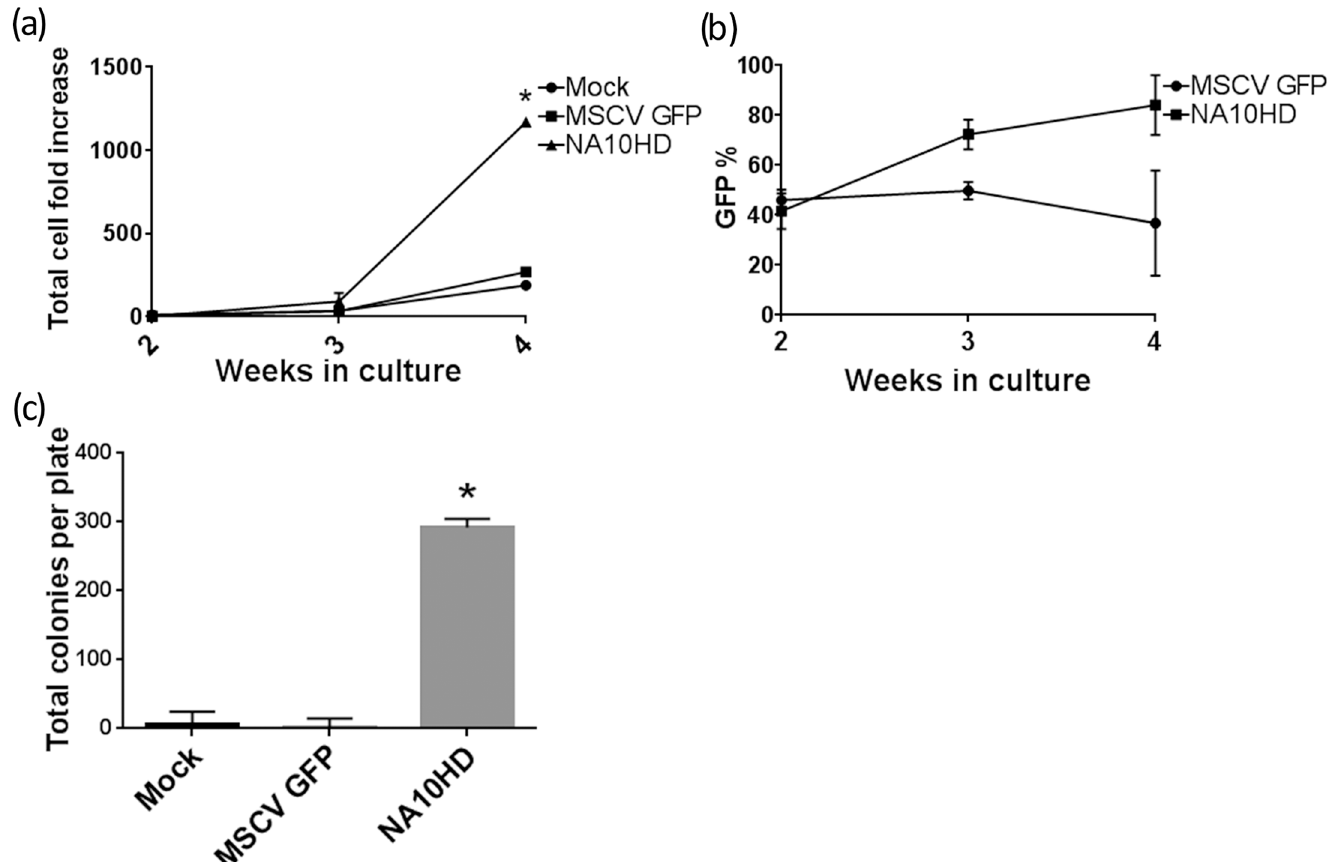
Fig 2. Biologic activity of NUP98-HOXA10HD in mouse bone marrow. (a) Growth curve of lineage depleted C57BL/6 mouse bone marrow cells transduced with GFP control or NUP98-HOXA10HD-GFP vector (NA10HD) as compared to untransduced mock cells grown in liquid culture, n = 2, at 4 weeks NA10HD has more expansion vs. Mock and MSCVGFP (p = 0.013 and p = 0.024 respectively, paired 2-tailed t-test, n = 2), (b) Percentage of GFP positive cells in liquid culture over time showing an enrichment of GFP positive cells in the NA10HD group over time, (c) CFU-C assay of mouse marrow cells that had been in culture for 39 days and plated at 6000 cells/plate, NA10HD has more colonies vs. Mock and MSCVGFP (p < 0.0001, unpaired 2-tailed t-test, n =